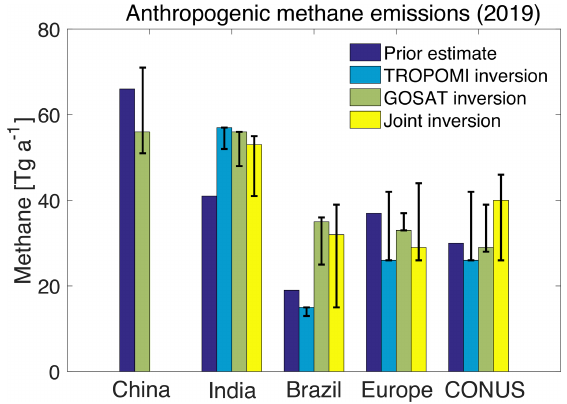
Figure 7. Annual anthropogenic methane emissions in 2019 for five major source regions, accounting for 56% of global anthropogenic emissions in the inversion of GOSAT data. The vertical bars repre- sent the range of posterior emissions from the ensemble of inver- sions. Europe is defined as west of 37 ◦ E. The CONUS is the con- tiguous United States. TROPOMI and joint inversion results are not shown for China because of concern over biases resulting from sea- sonal cloudiness and prior errors in the spatial distribution of coal emissions (see text).